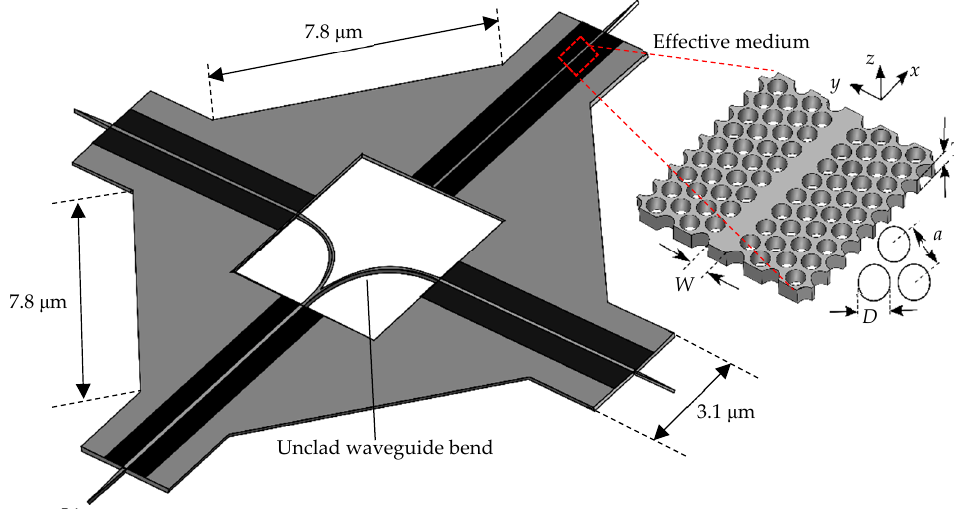
Figure 13. Design of proposed Y-branch with the effective medium section as inset. W = 80 μ m, T = 80 μ m, D = 45 μ m, P = 45 μ m.